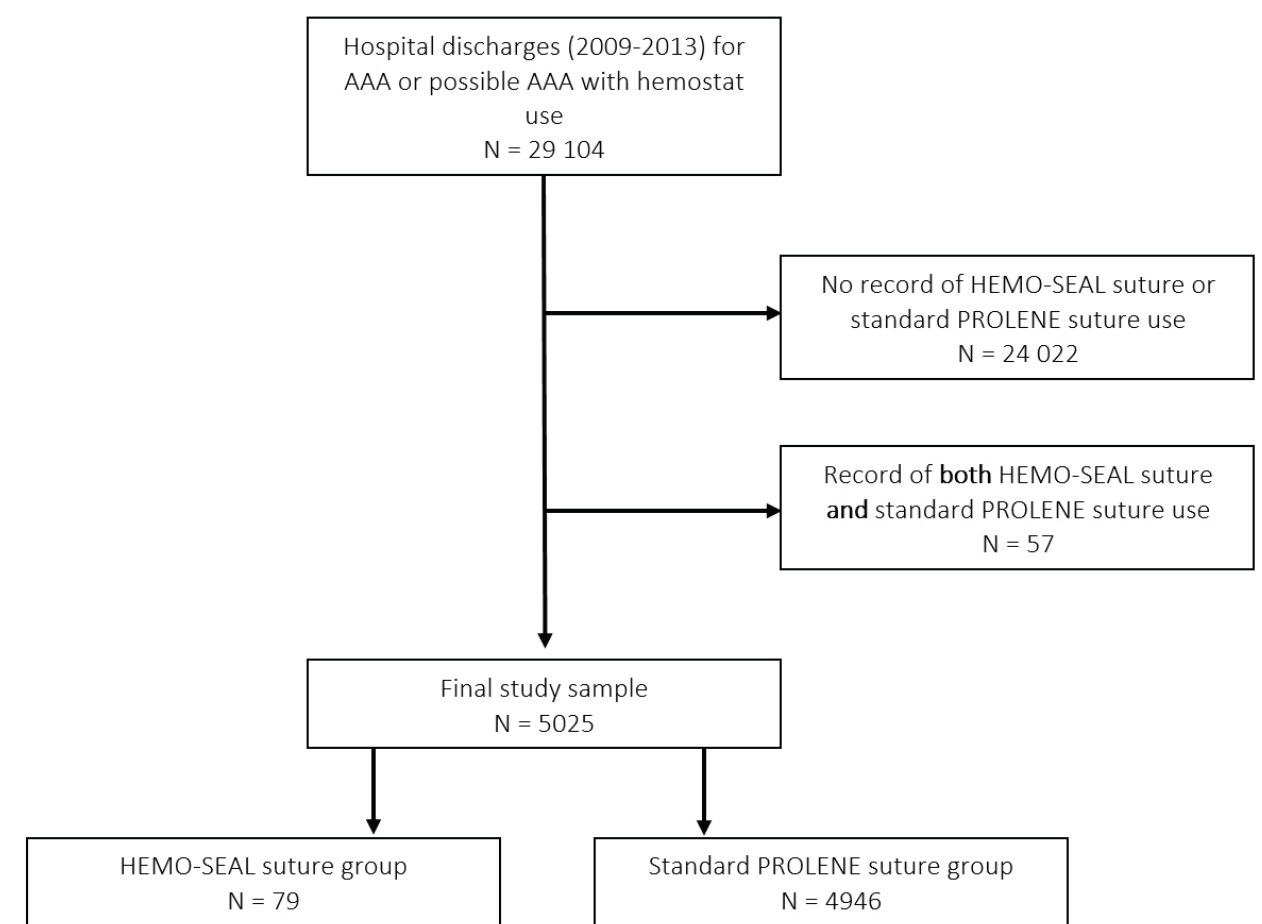
Figure 1. Flow Chart of the Study Sample Selection Process